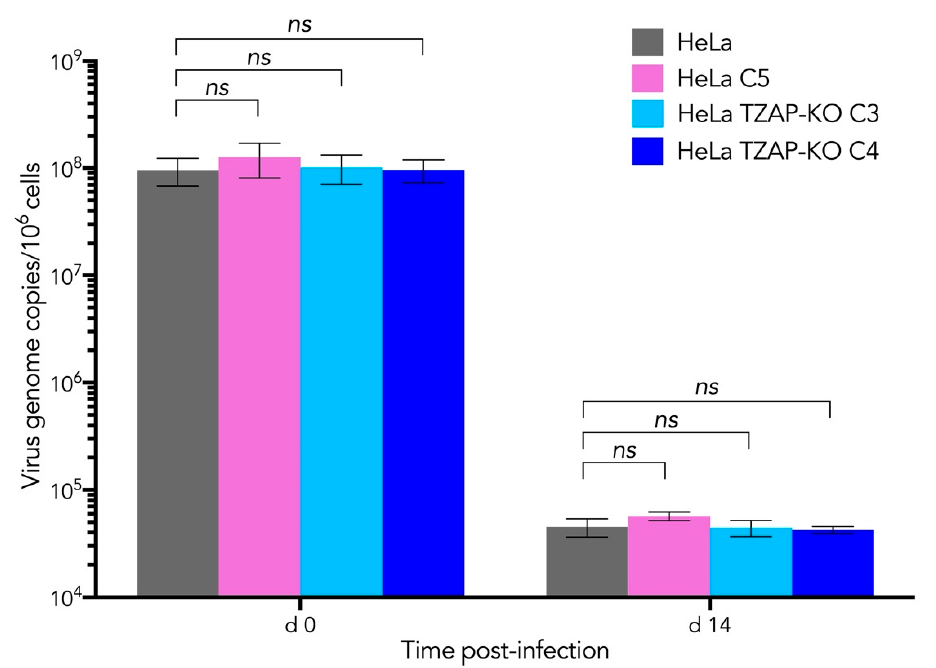
Figure 3. Telomere length does not influence HHV-6A integration into telomeres. The indicated HeLa cells were infected with wild-type GFP-reporter HHV-6A, and a sample was taken for DNA analysis. Fourteen days later after culturing the cells, a further DNA sample was taken. HHV-6A virus genome copies were enumerated by qPCR and normalized to cellular genome copies. Displayed are the mean number of virus genomes per million cells ( n = 3 ± SD). No statistical significancy (ns) was detected between the different HeLa cells shortly after infection (d0) and 14 days post-infection (d14).